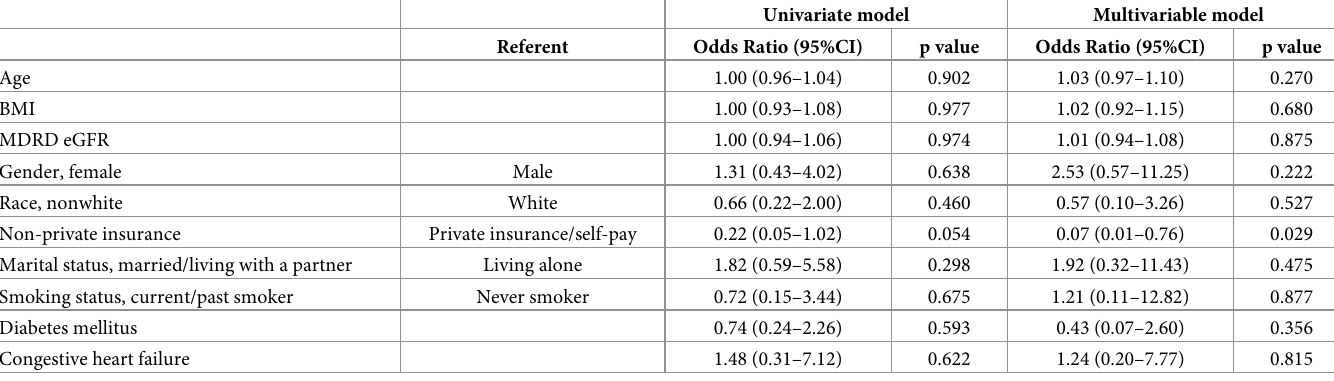
Table 2. Univariate and multivariable regression analysis of factors impacting the HoD